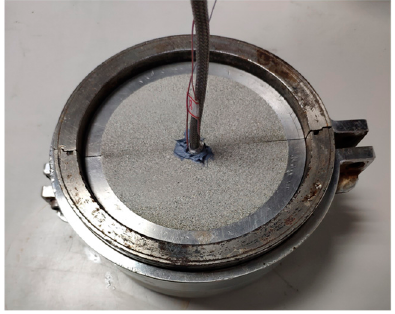
Figure 5. Specimen with the thermal probe.,